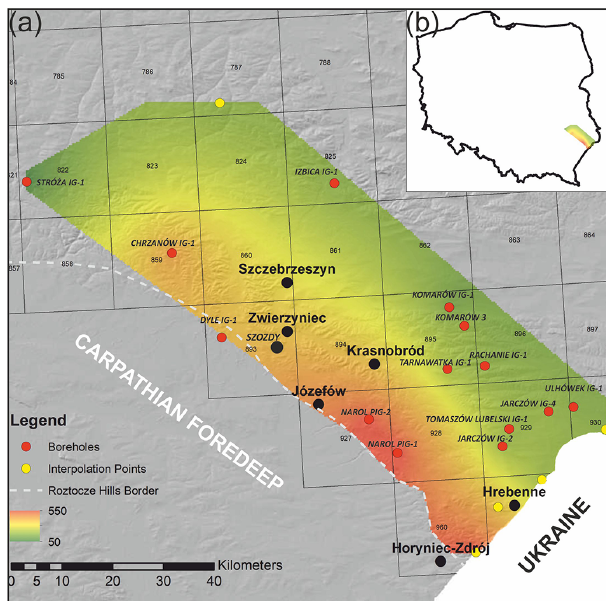
Figure 8. (a) Thickness pattern of Campanian deposits in the Roz- tocze Hills based on well data; (b) general map of Poland with study area. Squares with numbers represent the associated geological map sheets (https://geologia.pgi.gov.pl/, last access: 3 January